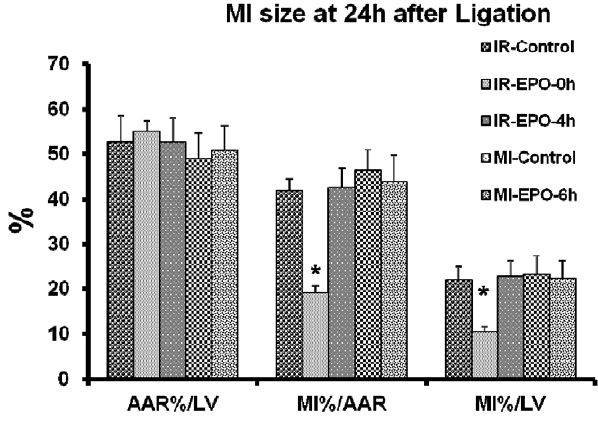
Figure 2. Size of myocardial infarction. Area of myocardium at risk (AAR) and size of myocardial infarction (MI) 24 hrs after permanent occlusion of the left descending coronary artery or after 2 hrs of occlusion followed by 22 hrs of reperfusion. rhEPO is administered at the time of reperfusion (IR-EPO-0 h) or 4 hrs after beginning of reperfusion (IR-EPO-4 h) or 6 hrs after permanent coronary occlusion (MI-EPO-6 h). Data presented as means 6 SEM. AAR is presented as % of left ventricle (LV). MI is presented as % of AAR or % of LV. *- p , 0.05 vs all other group (Bonferroni post hoc comparison).